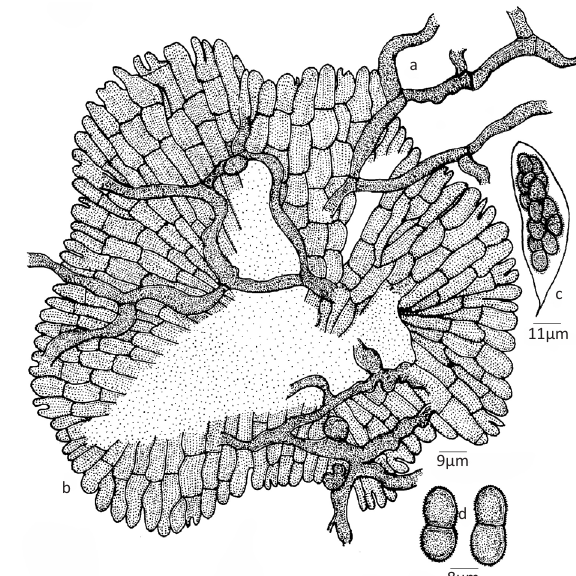
Figure 2. Asterina derridicola sp. nov. a - Appressoriate mycelium; b - Thyriothecium; c - Ascus; d - Ascospores